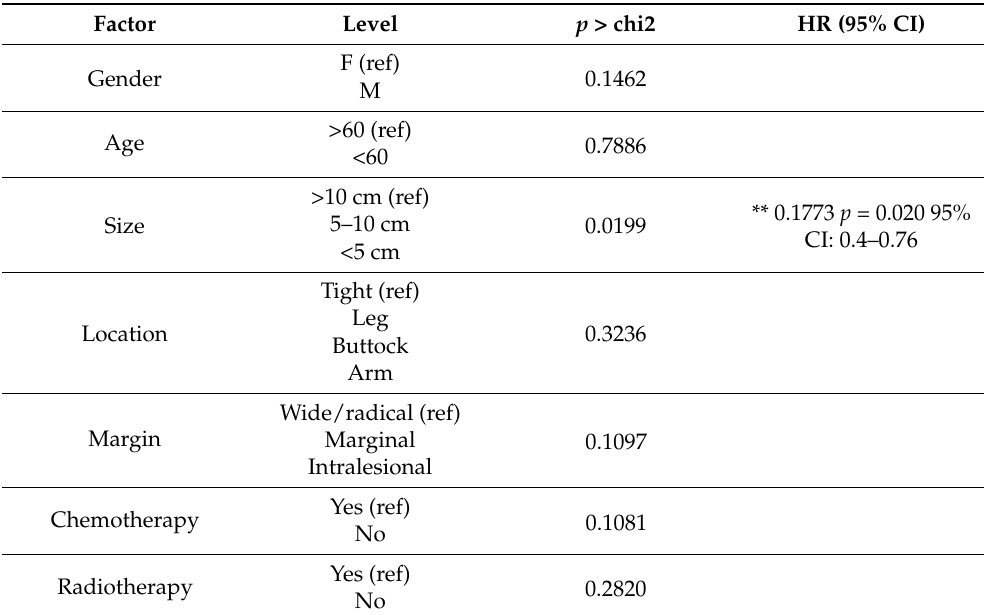
Table 4. Kaplan–Maier Disease-free survival (DFS) estimates from patient characteristics. ** HRs unadjusted to each other in multivariable analysis. Results did not change upon an adjustment in multivariate